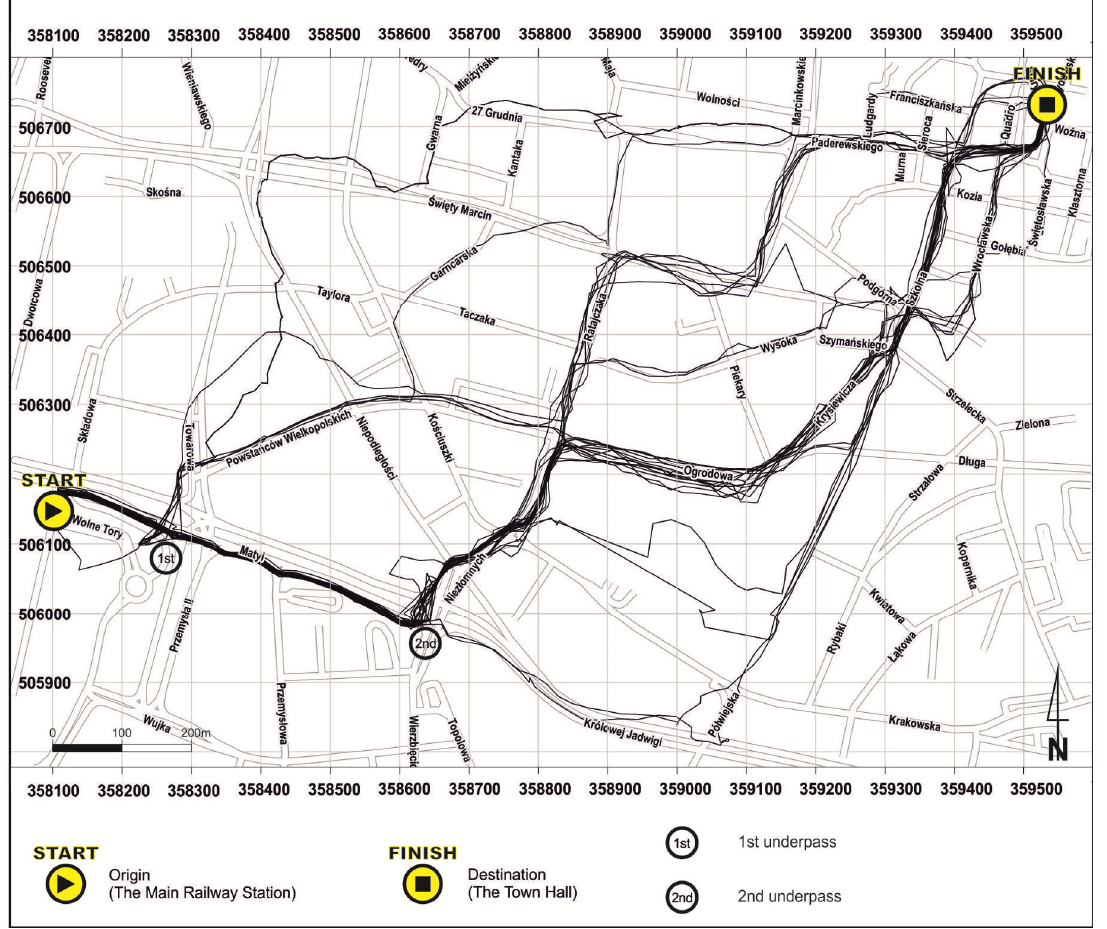
Figure 1. Map with non-symbolized trajectories—‘raw’ presentation of 30 tracks.